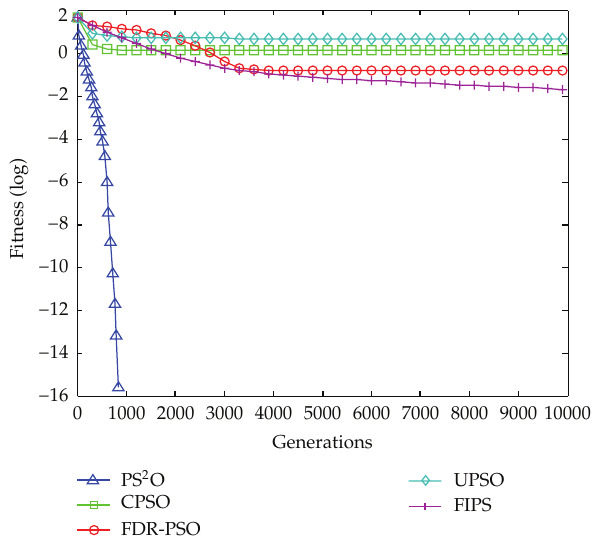
Figure 8: The median convergence results of Weierstrass